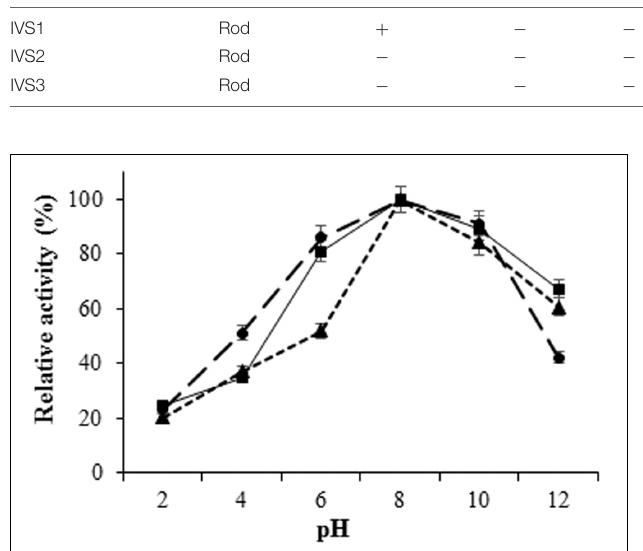
TABLE 3 | Morphological and biochemical characterization of proteolytic bacterial isolates from Helicoverpa armigera . Bacterial isolate